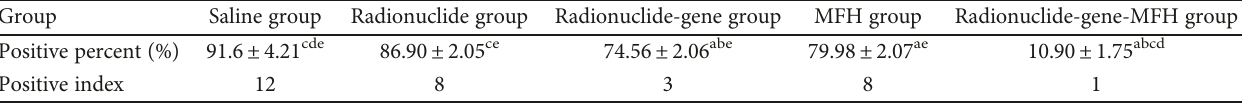
Table 3: Livin protein expression of hepatoma tissues after di ff erent treatments tested by IHC (mean ± s, n = 5 ). Group Saline group